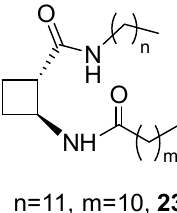
Figure 18. Cyclobutane-containing amino acid derivatives with alkyl tails.